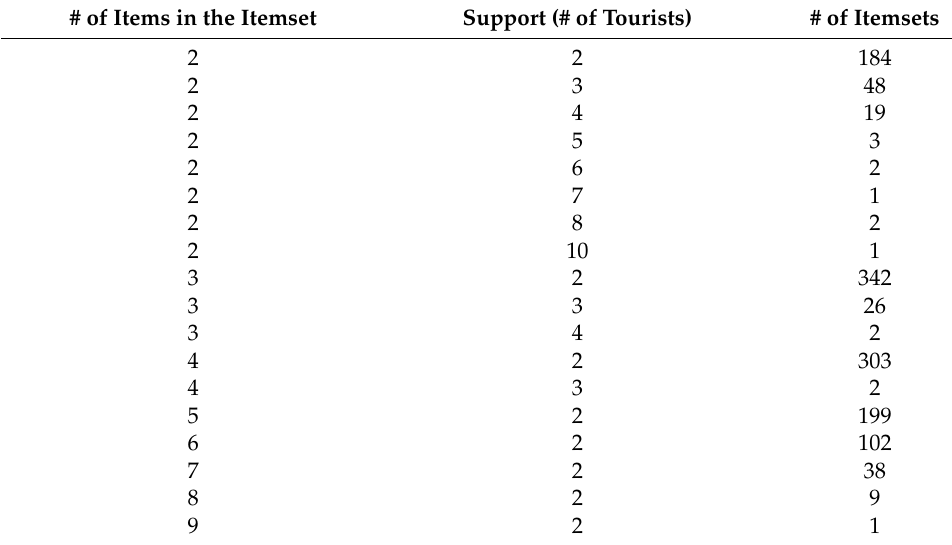
Table 4. Distribution of itemsets for interpretation 1.